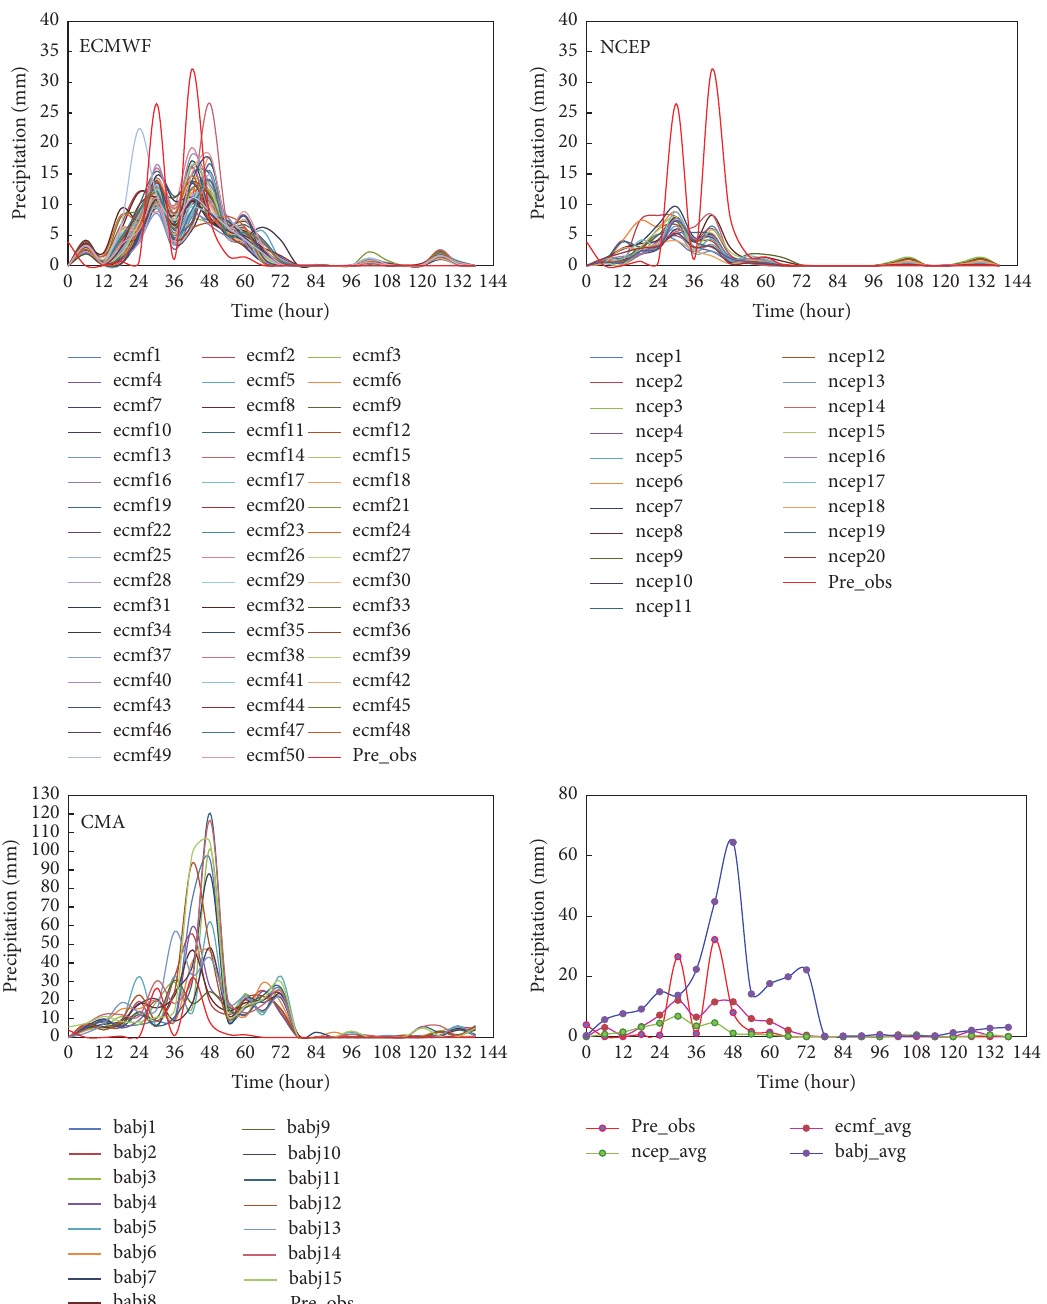
Figure 2: Comparison of the predicted precipitation (20070809 event) from ECMWF, NCEP, and CMA ensemble models.